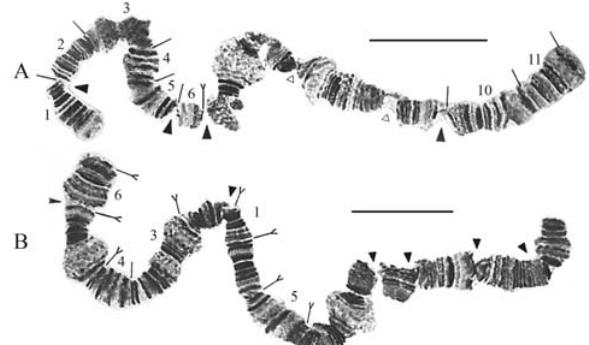
Figure 11 - Photomicrographs of chromosome 3 of A: Drosophila arapuan , B: D. arassari . Homology with the standard could not be com- pletely established. Scale bars = 30 μ m.